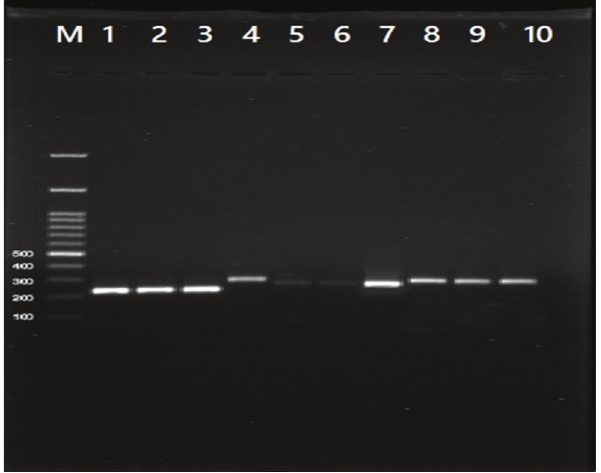
Figure-1: Amplicons of the genes 16S rRNA , sec , sed, and nuc gene. Lane (M) DNA ladder 100 bp; lanes (1-3) positive samples of 16S rRNA gene at 228 bp; lane (4) positive sample of sec gene at 284 bp, lanes (5-7) positive samples of sed gene at 278 bp and lanes (8-10) positive samples nuc gene at 270